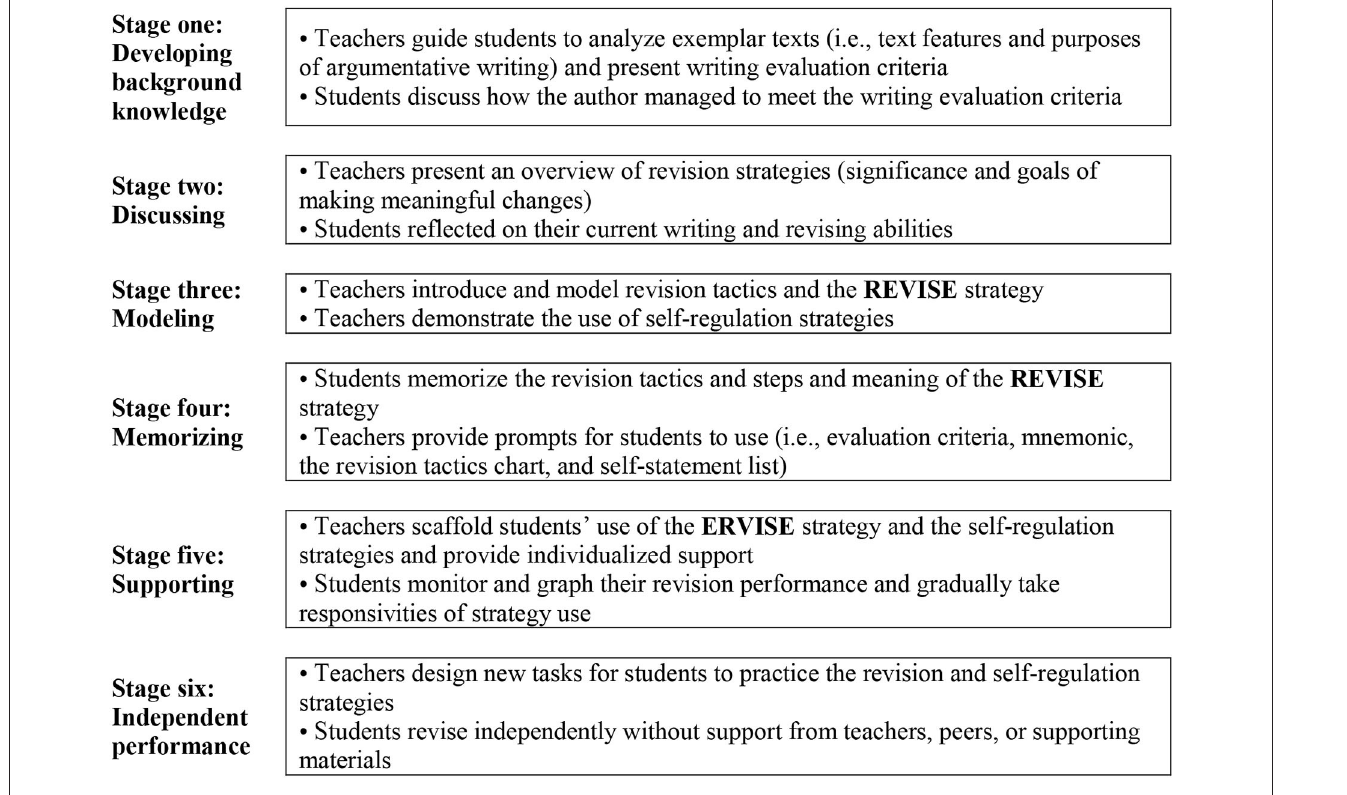
FIGURE 1 | Six stages of the SRSD revising instruction (adapted from Harris et al.,